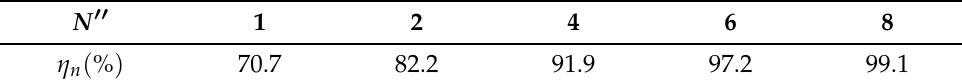
Table 2. Cumulative percentage variance of energy for various numbers of time-related modes (left ear).